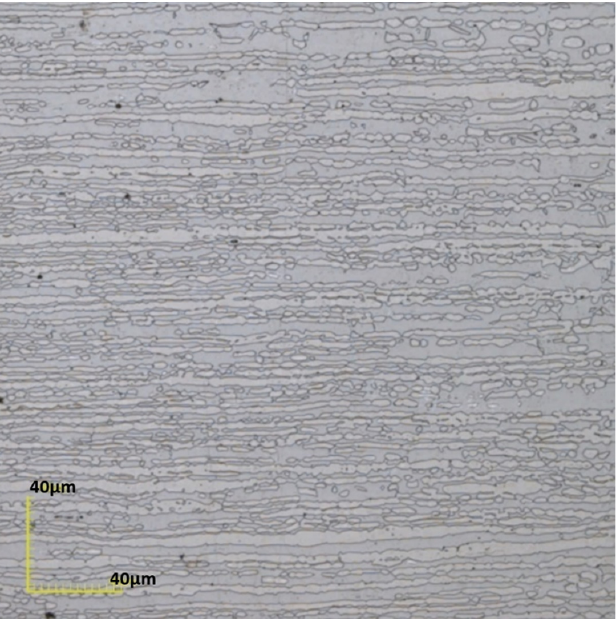
Figure 3. Representative microstructure of the BM. Electrolytic etching with 10% oxalic acid. Confocal microscopy (model Olympus OLS400, Shinjuku, Tóquio, Japão), 1075× magnification.